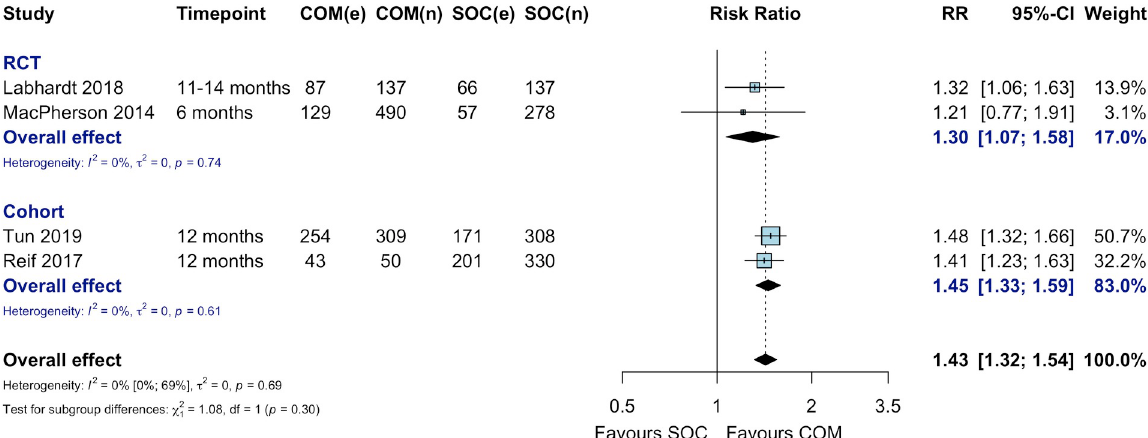
Fig 4. ART retention at 6–12 months among HIV-positive individuals. COM, community ART initiation; e, number of events; n, number of participants; RCT, randomized controlled trial; RR, risk ratio; SOC, standard of care. MacPherson 2014 reflects cluster-adjusted numbers based on the Cochrane method of adjusting for the design effect.